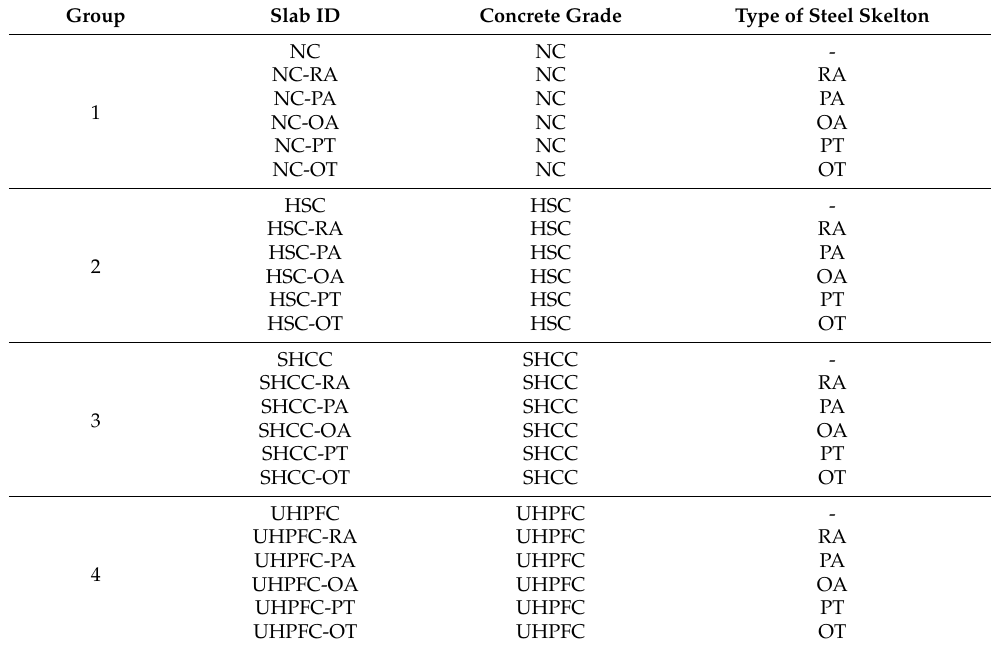
Table 1. Basic information of tested specimens.